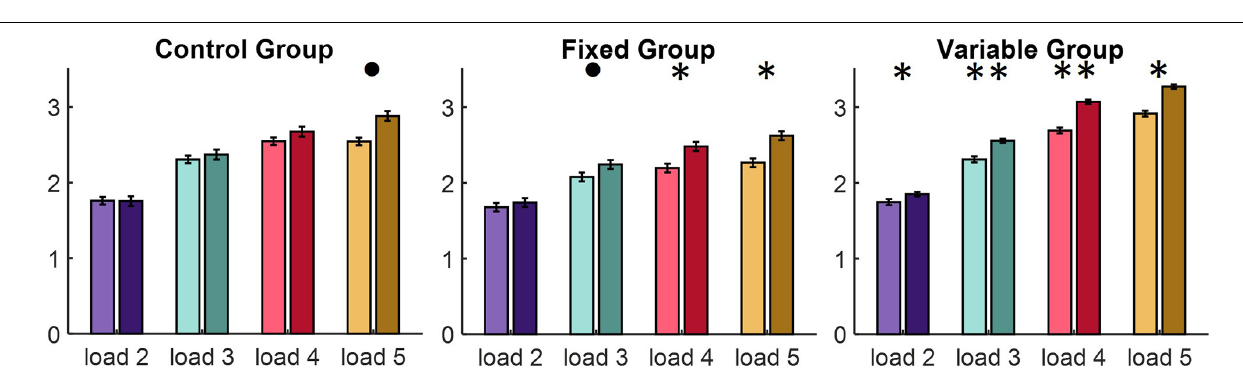
FIGURE 3 | The average K values for each set size in the two tests presented separately for each group. Lighter colors in the pair correspond to the pre-training measurement and darker to the post-training measurement. Asterisks indicate statistical significance: • p < 0.08, ∗ p < 0.05, ∗∗ p <